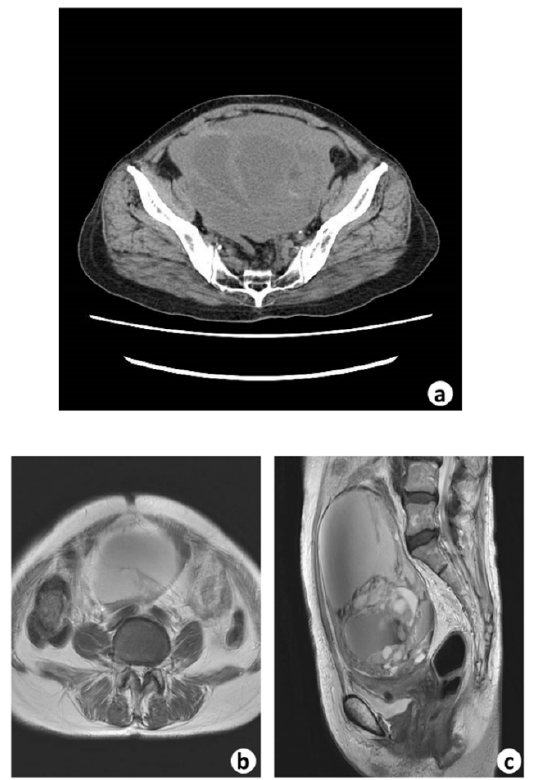
Figure 1. CT and MRI images. ( a ) Pelvic CT shows a large cystic tumor occupying the pelvic cavity. ( b ) T2-weighed axial MRI of the pelvis showing a large left ovarian cystic tumor. ( c ) T2-weighed sagittal MRI of the pelvis showing a large multilobular ovarian cystic tumor.